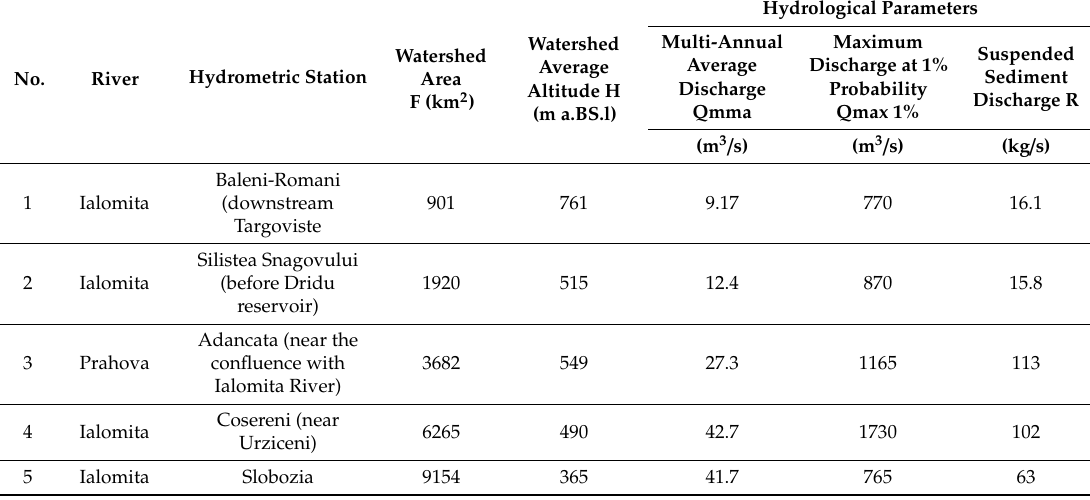
Table 1. Multiannual hydrological parameters recorded in various control sections of Ialomita River Basin and its major tributary Prahova River (see water management scheme—Figure S1); a.BS.l—above Black Sea